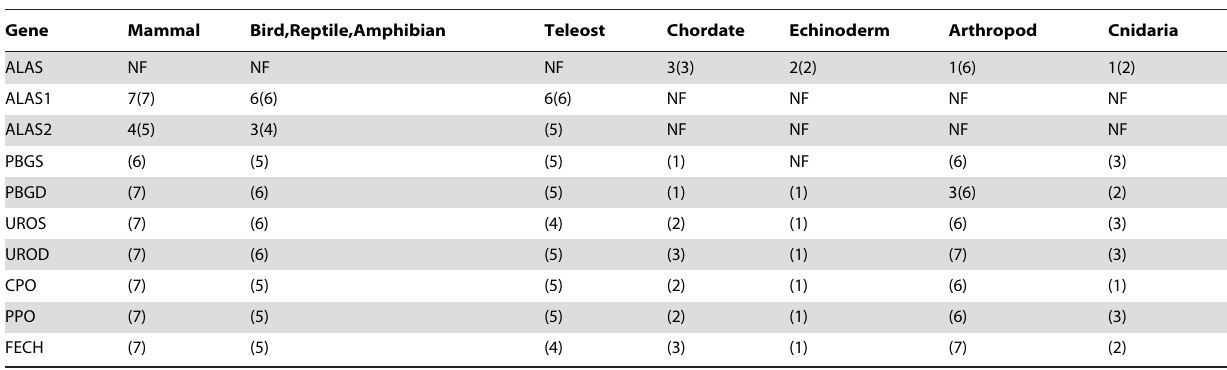
Table 6. HRM_t in protein sequence.